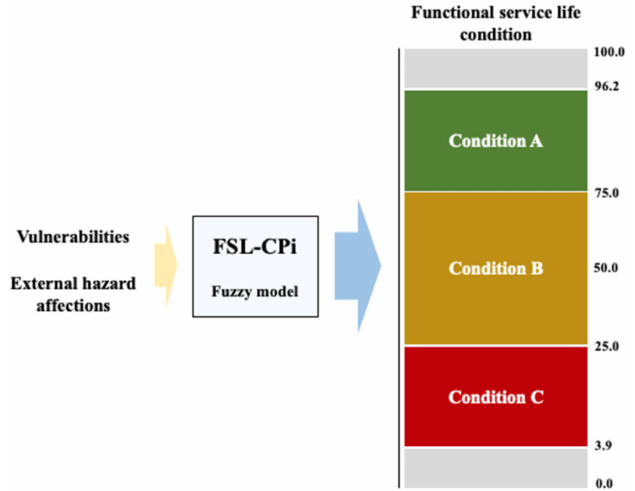
Figure 7. Functional service life range conditions concerning a concrete pavement